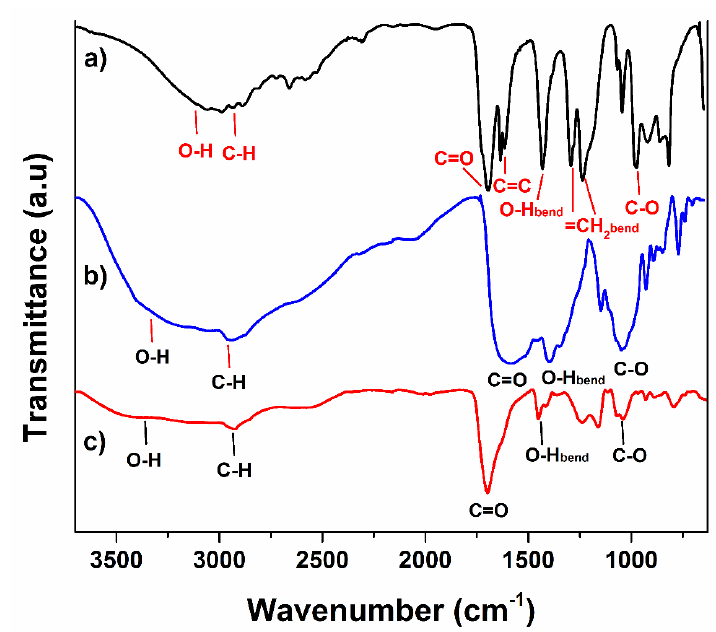
Figure 2. FTIR spectra of ( a ) agar, ( b ) PAAc, and ( c ) hydrogel.